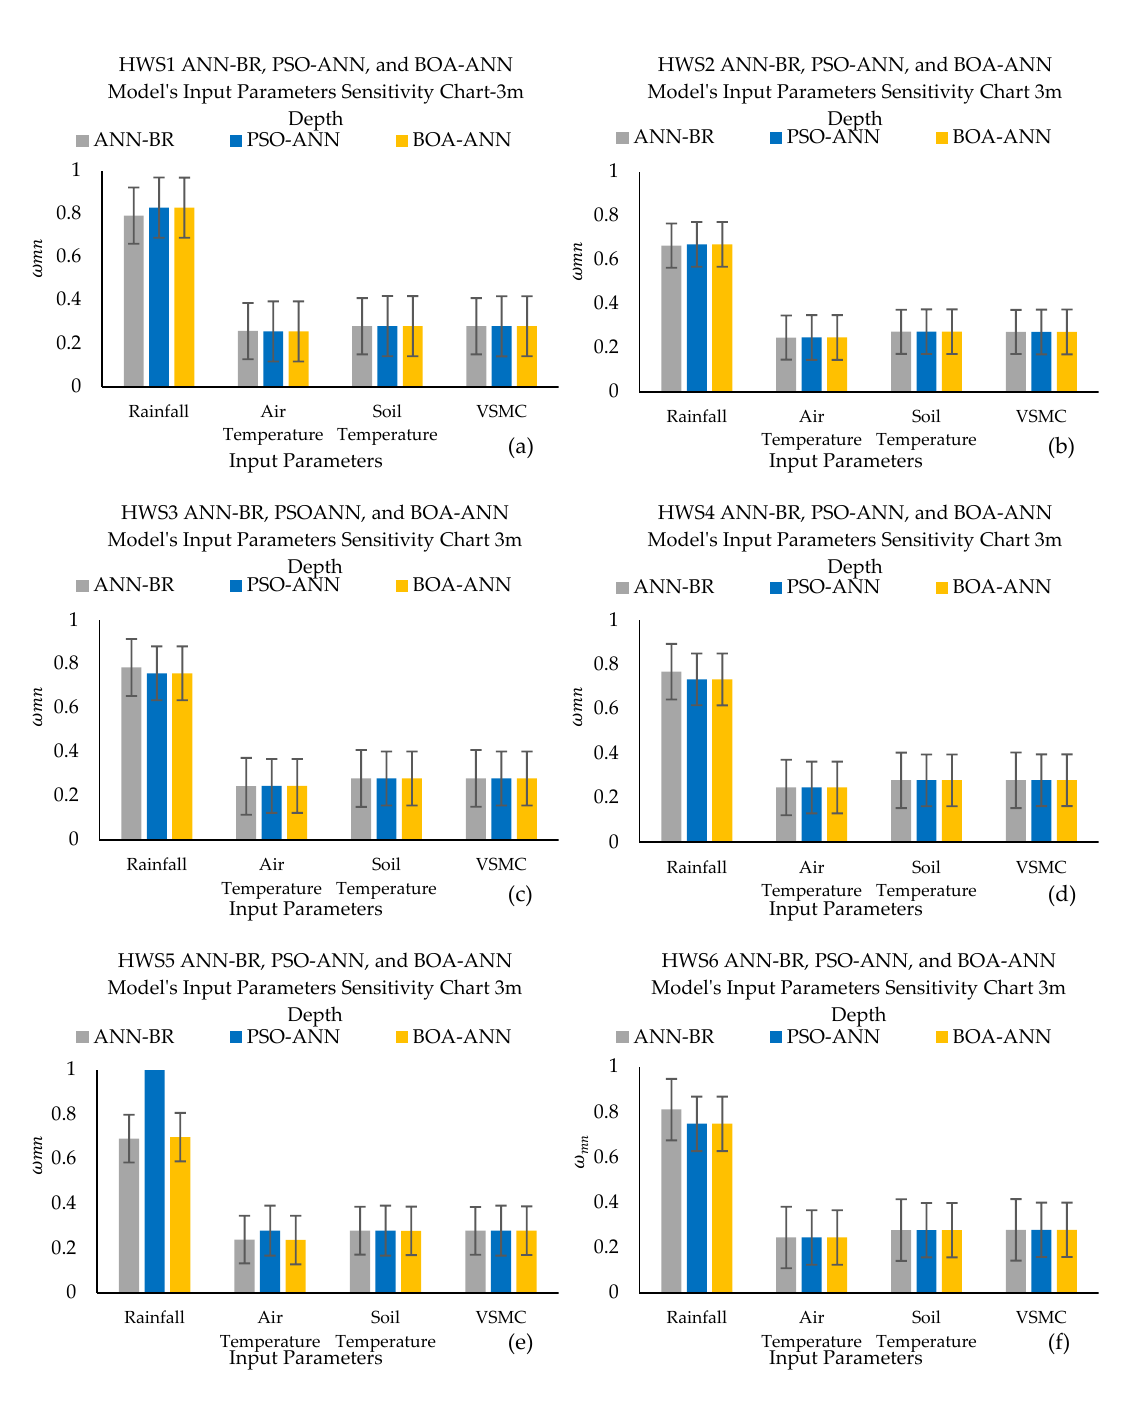
Figure A7. The sensitivity factor of input parameters on the predicted output for the ANN-BR, PSO- ANN, and BOA-ANN at 3 m depth ( a ) HWS 1 ( b ) HWS 2 ( c ) HWS 3 ( d ) HWS 4 ( e ) HWS 5 ( f ) HWS 6.